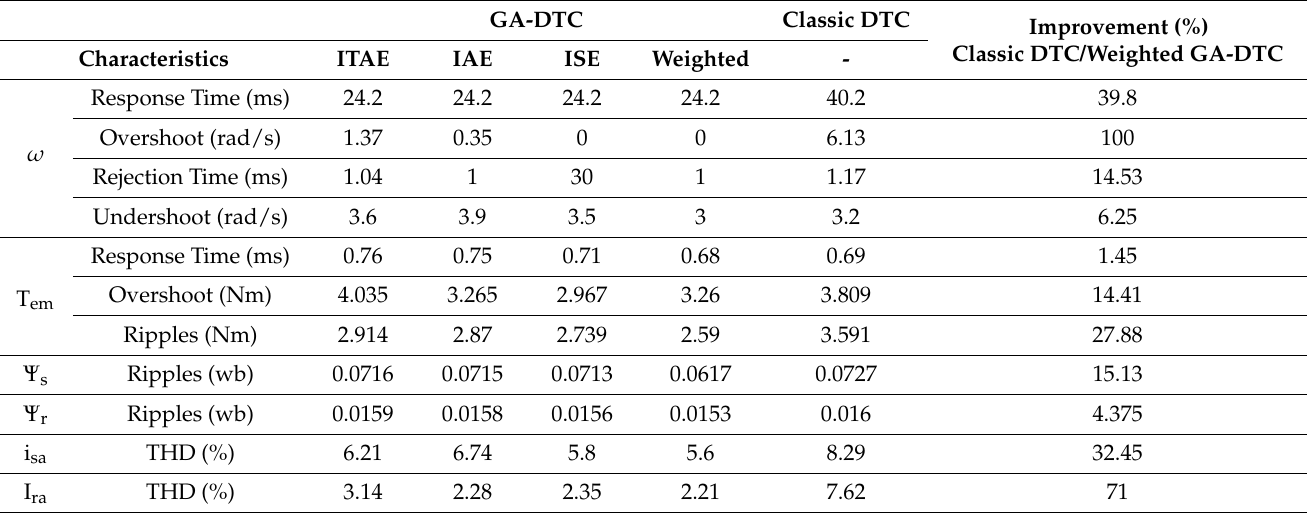
Table 3. Performance measures ofclassic DTC and